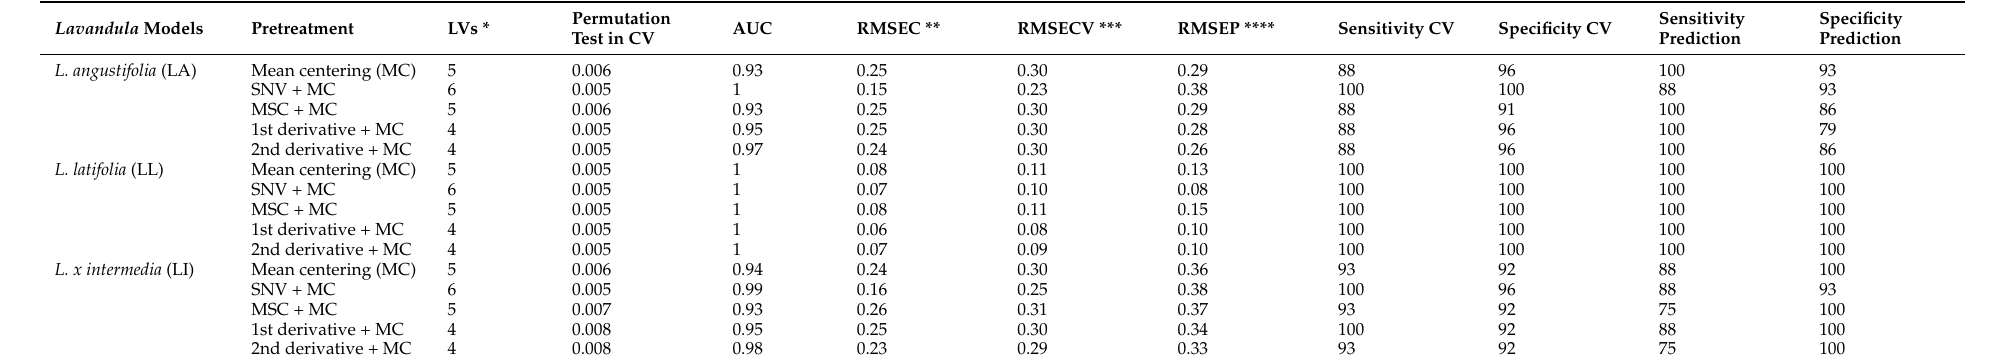
Table 4. Results of PLS-DA models applied on Lavandula dataset for both cross-validation of the calibration set and prediction of test set using different pretreatment methods.